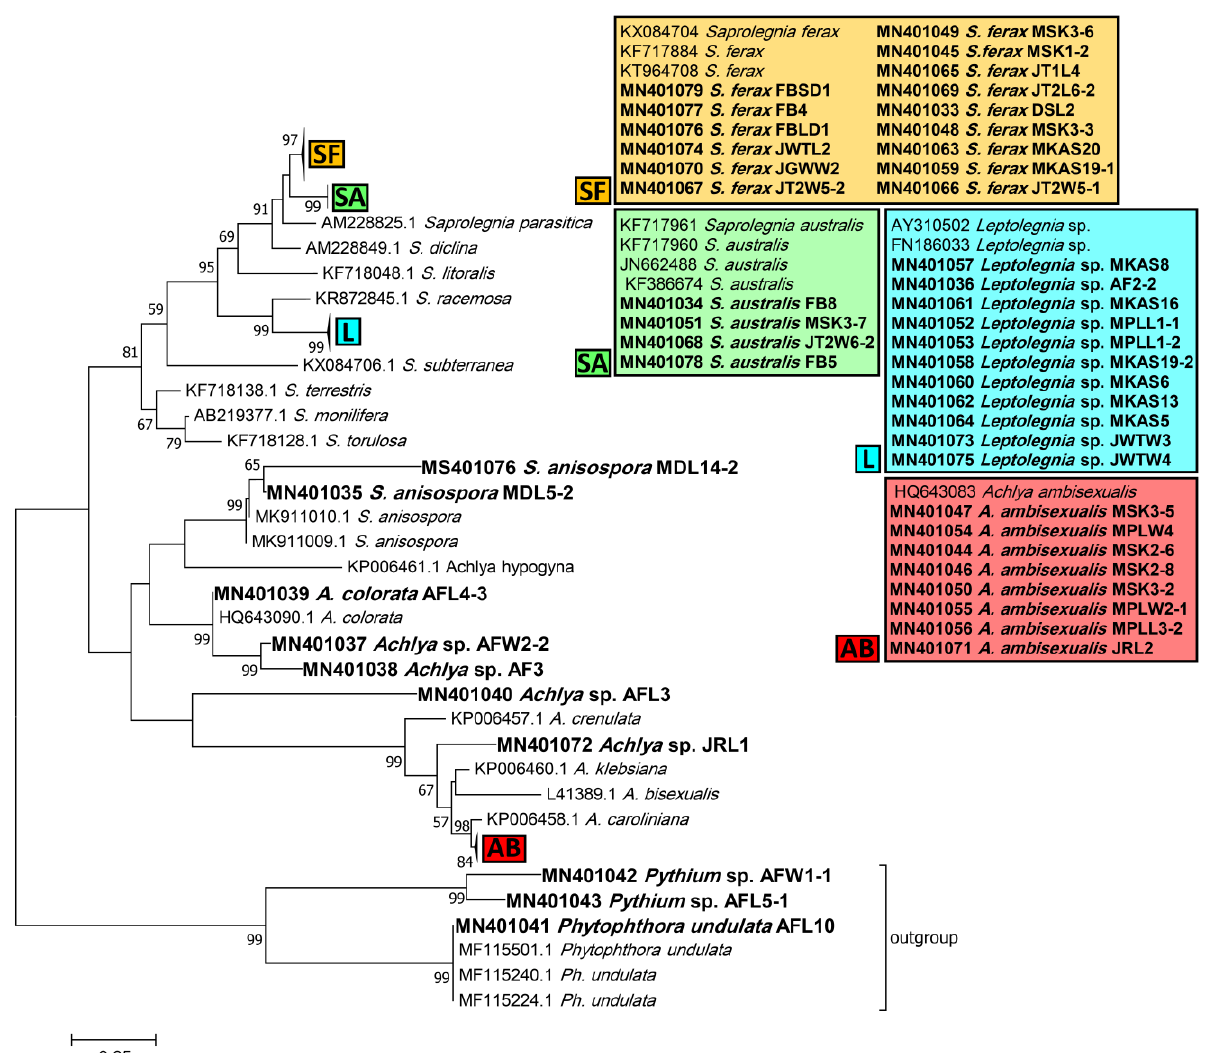
Figure 1. Composition of oomycete (Saprolegniales and Peronosporales) ( A ) and fungal ( B ) taxa isolated from 12 lakes of Northeast Germany in 2018.